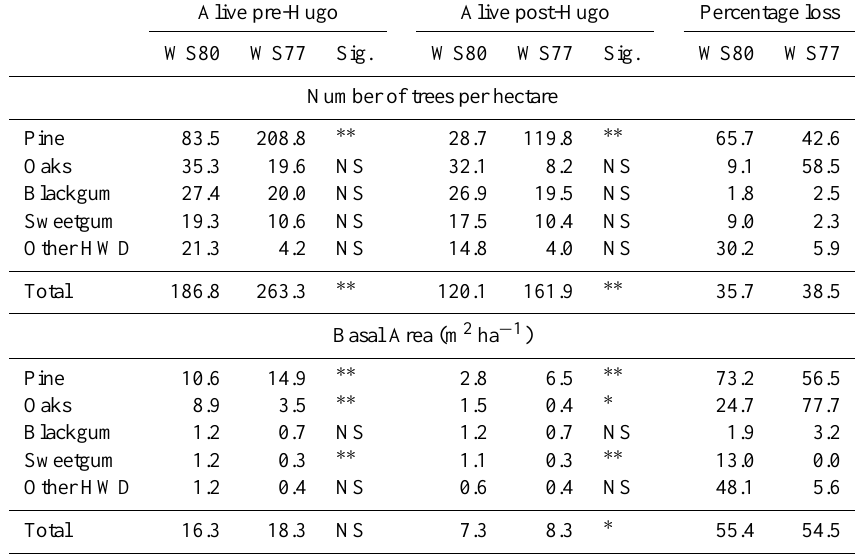
Table 3. Results of regeneration counts made during inventories of WS77 and WS80 in 1991. All values represent the number of trees per hectare. Statistical significance as denoted in Table